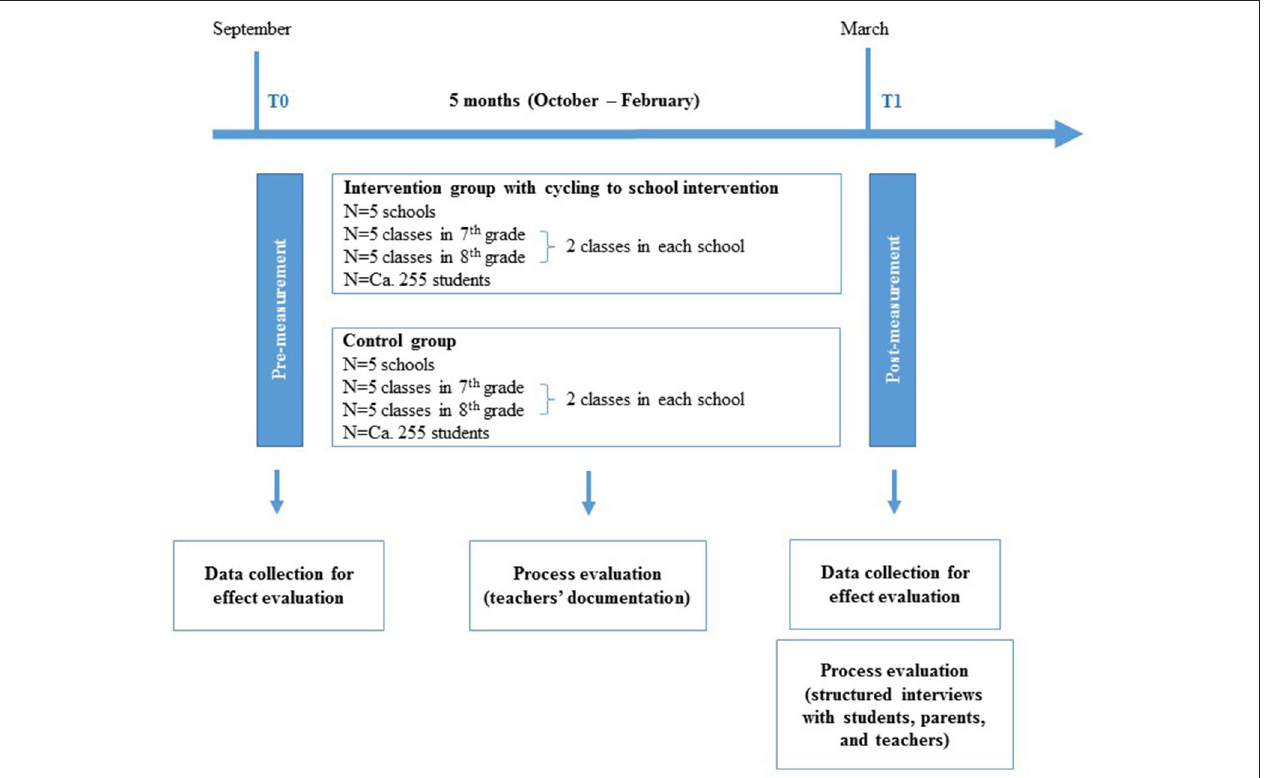
FIGURE 4 | Study design of the planned cycling to school intervention. N , sample